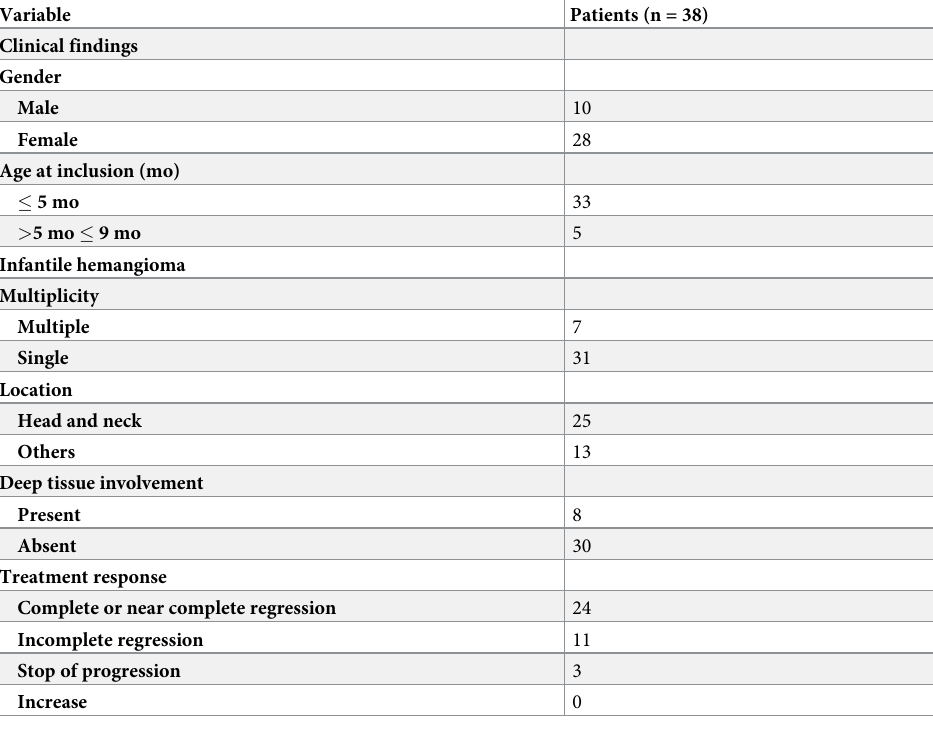
Table 1. Baseline clinical